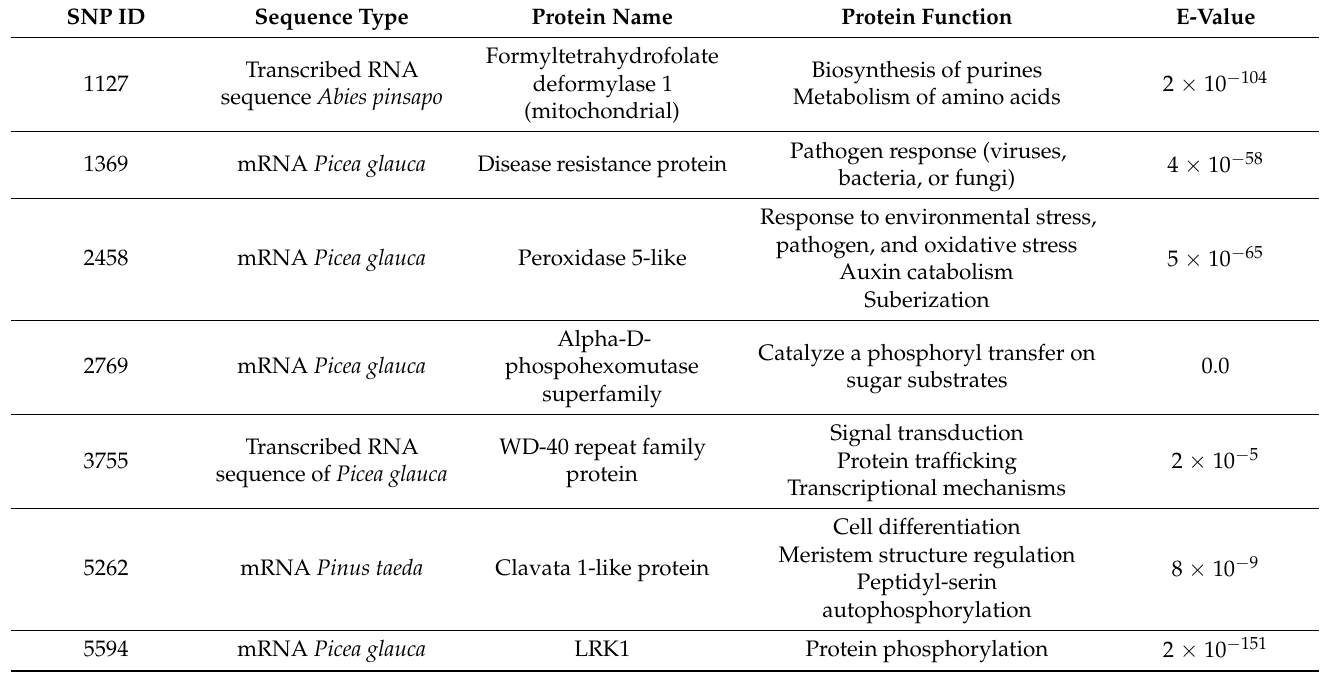
Table 3. BayeScan results of de novo assembly obtained for Abies marocana separating between saplings and old trees in both study sites. For the identified SNPs, the sequence type, the name and functions of the proteins, and the E-value are shown (lower values indicate increasing probability for protein similarity). Protein functions were obtained from UniProt. The 4-digit number used as ID for the SNPs indicates the position in our genetic